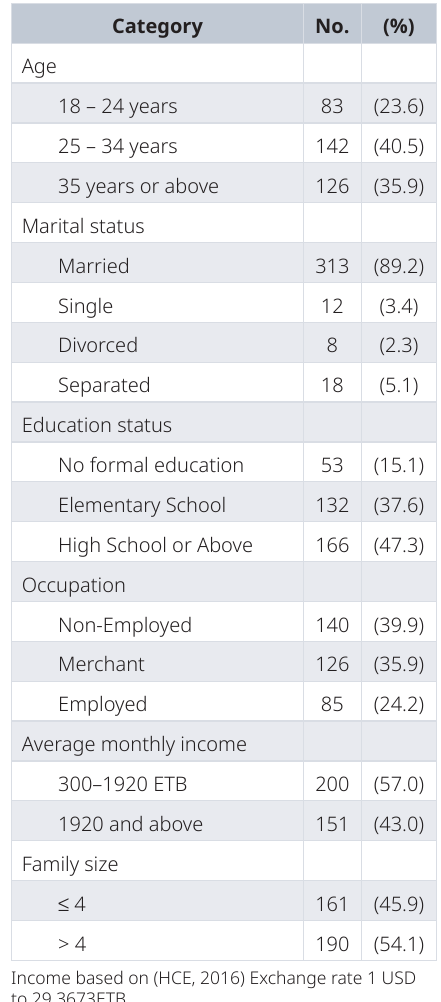
Table 1. Socio-demographic characteristics of antenatal care clinic attendants at selected health centers in Hawassa, Southern Ethiopia,